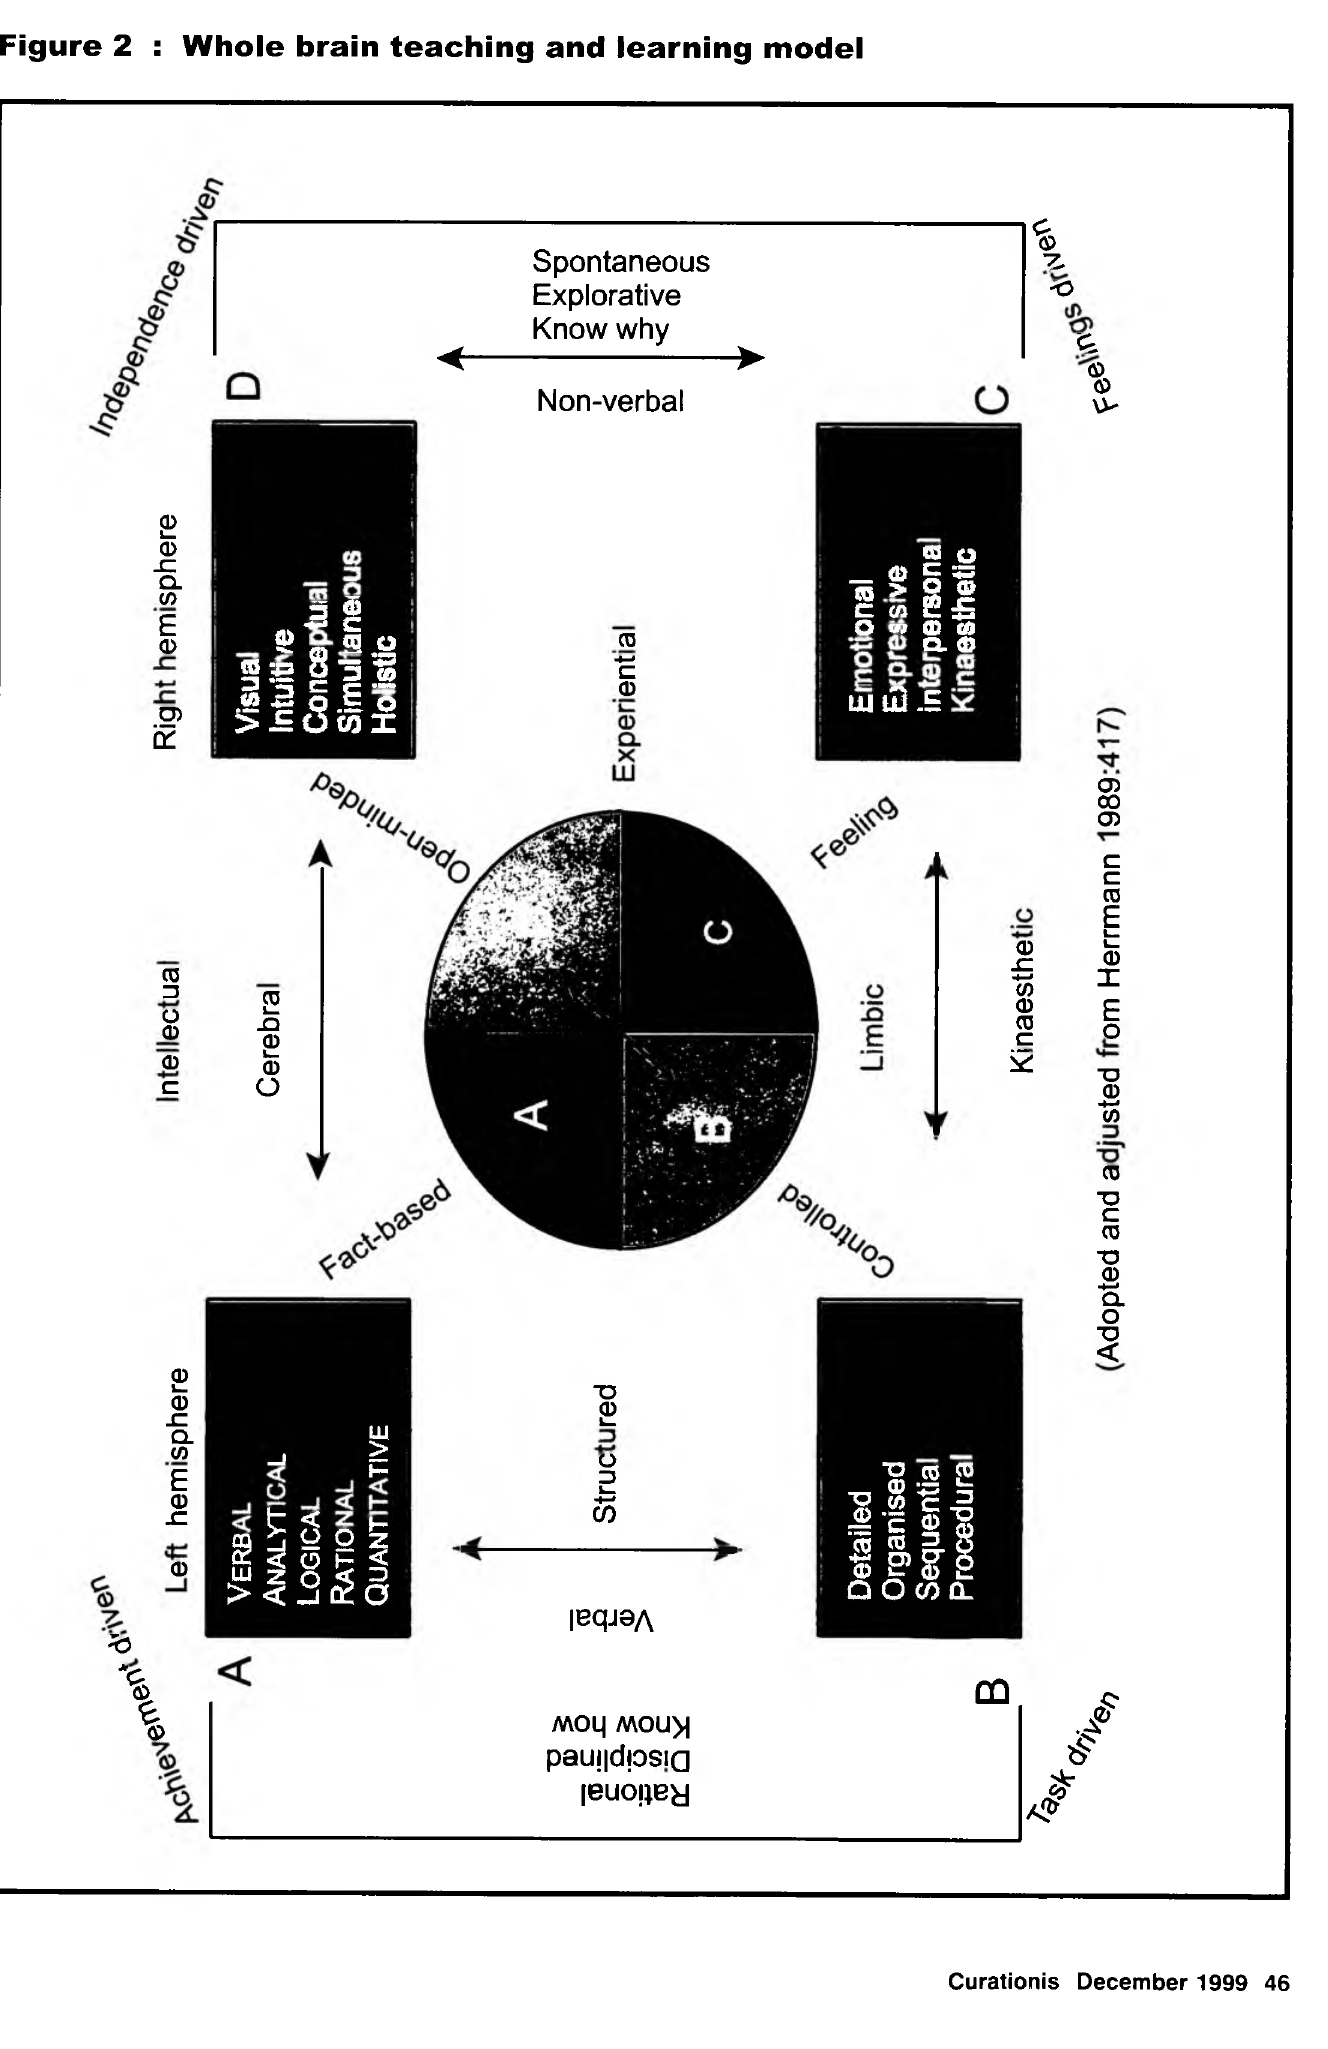
Figure 2 : Whole brain teaching and learning model